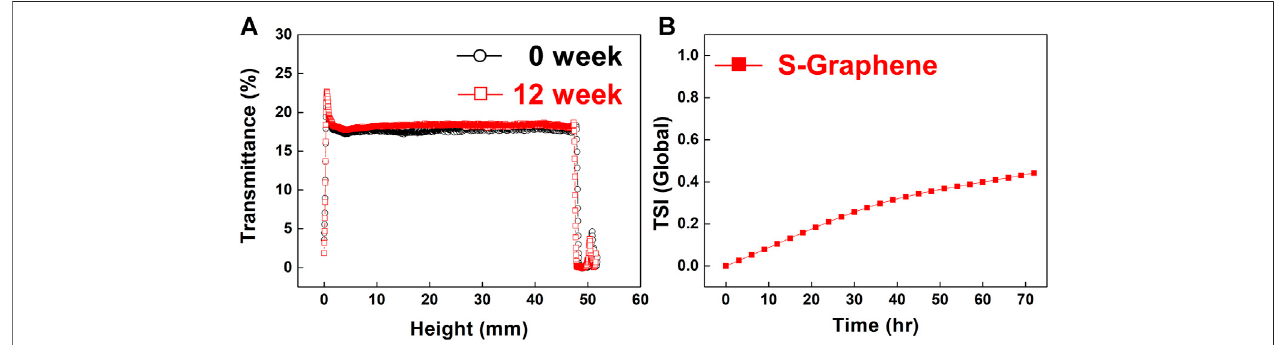
FIGURE 7 | (A) Transmittance of aqueous dispersion of water-dispersible graphene sheets as a function of the solution height at 0 and 12 weeks. (B) TSI of the dispersion over time.